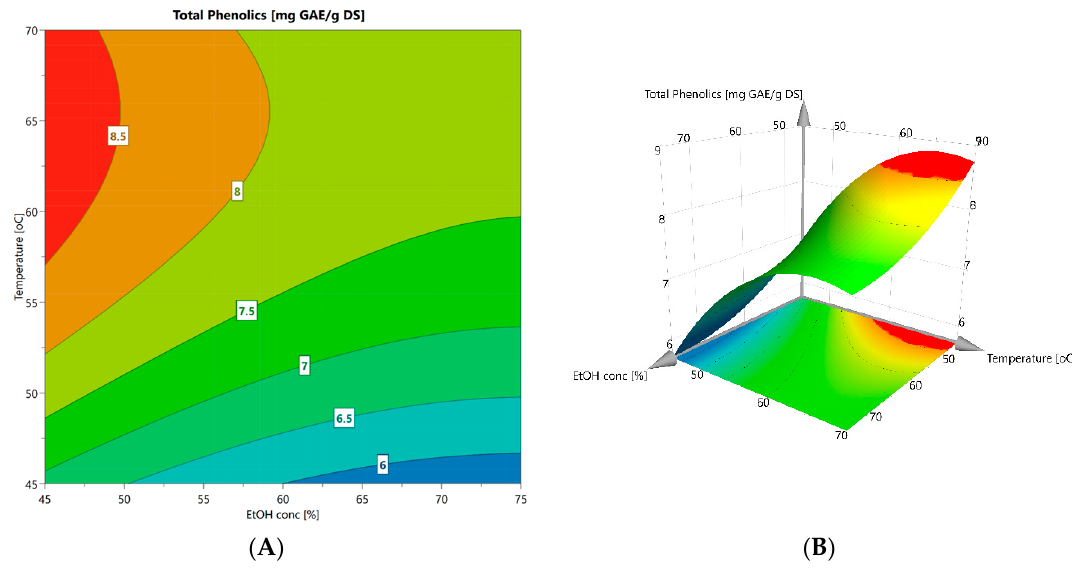
Figure 6. Contour ( A ) and response surface ( B ) plots at t = 60 min for extraction of phenolic acids from